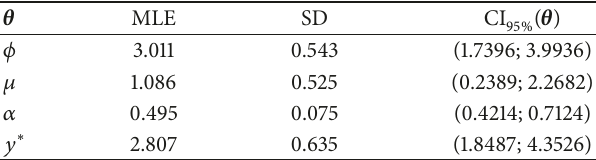
Table 10: MLE, standard deviation, and 95 % confidence intervals for 𝜙 , 𝜇 , 𝛼 , and 𝑦 ∗ related to the GG distribution.